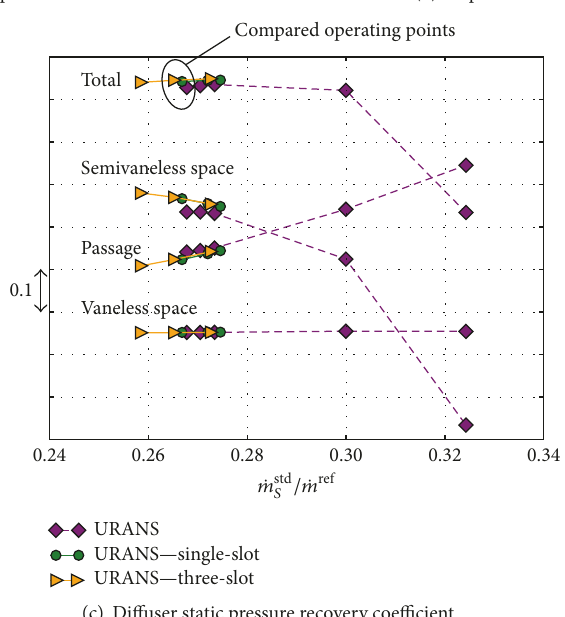
Figure 4: Performance of the